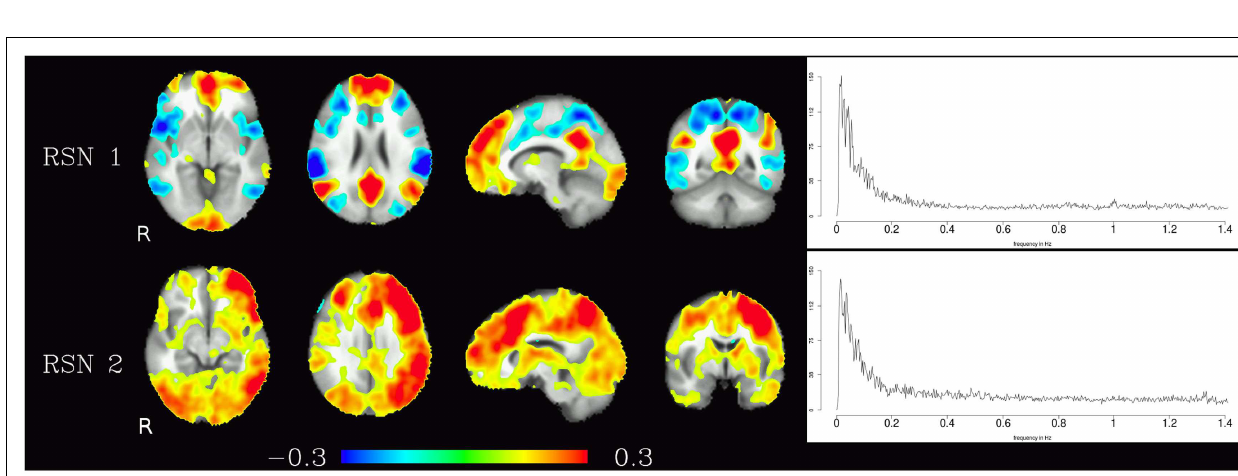
FIGURE 2 |Temporal ICA components representing high-frequency fluctuations in brain regions commonly associated with resting-state networks . Figure layout as in Figure 1 .